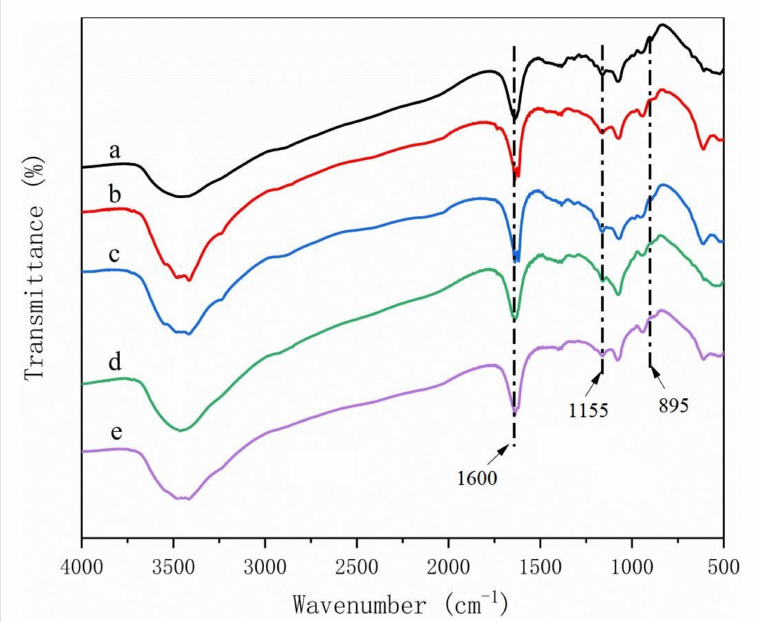
Figure 8. FTIR spectra of CMCs derived from ( a ) pine wood, ( b ) bamboo culm, ( c ) pine needles, ( d ) bamboo leaves, or ( e ) hemp